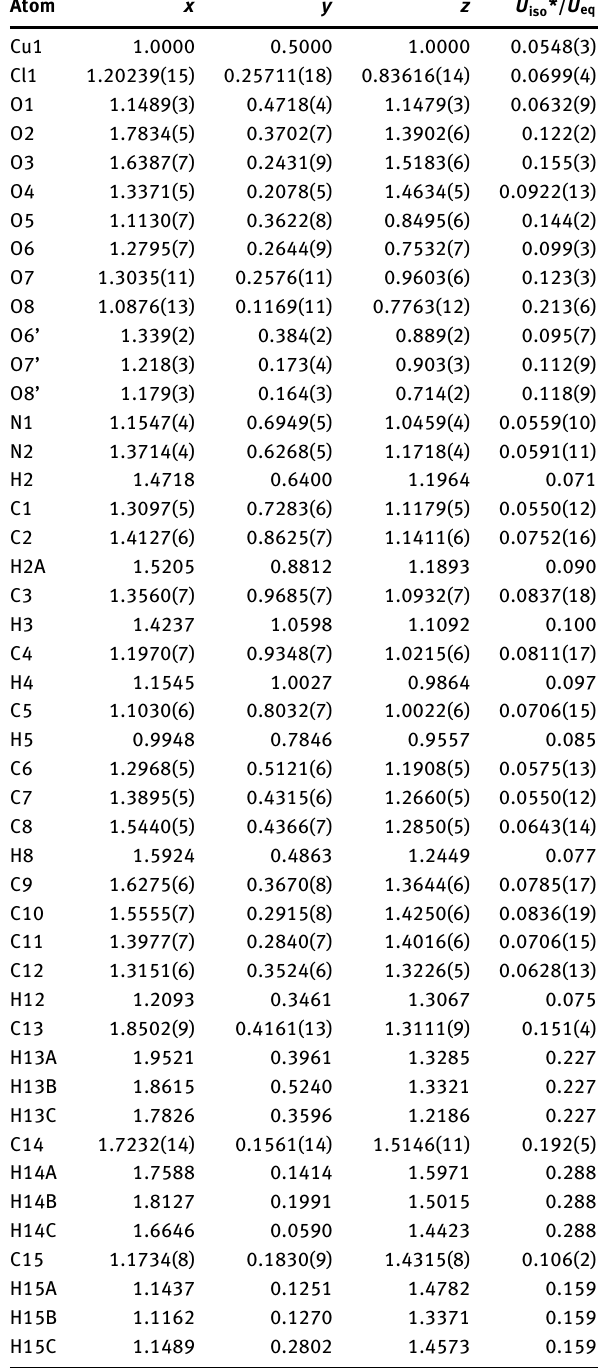
Table 2: Fractional atomic coordinates and isotropic or equivalent isotropic displacement parameters (Å 2